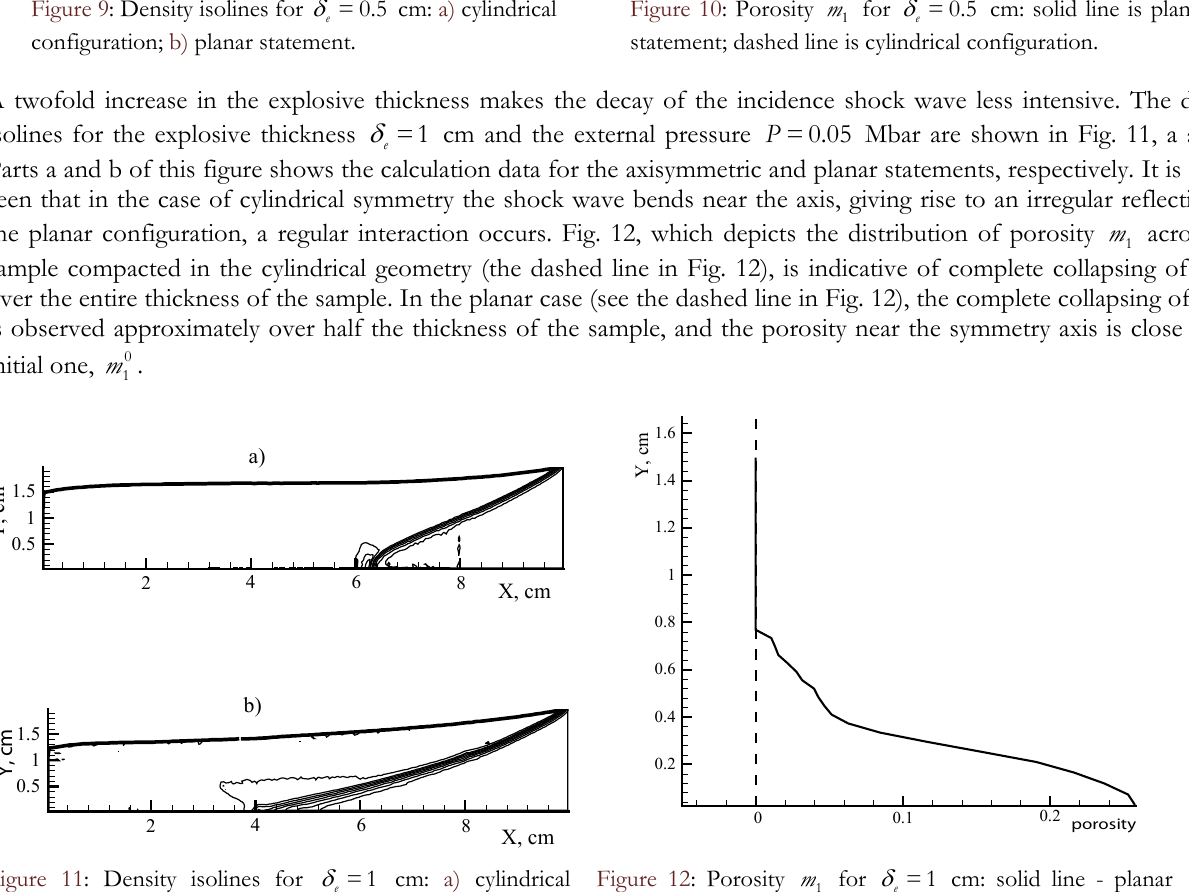
Figure 11: Density isolines for =1 configuration; b) planar configuration.